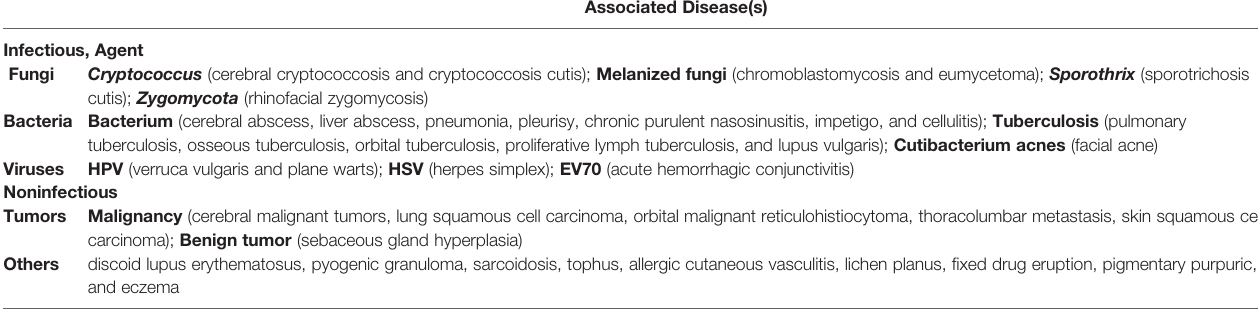
TABLE 7 | Main differential diagnoses of phaeohyphomycosis in China. Associated Disease(s) Infectious, Agent Fungi Cryptococcus (cerebral cryptococcosis and cryptococcosis cutis); Melanized fungi (chromoblastomycosis and eumycetoma); Sporothrix (sporotrichosis cutis); Zygomycota (rhinofacial zygomycosis) Bacteria Bacterium (cerebral abscess, liver abscess, pneumonia, pleurisy, chronic purulent nasosinusitis, impetigo, and cellulitis); Tuberculosis (pulmonary tuberculosis, osseous tuberculosis, orbital tuberculosis, proliferative lymph tuberculosis, and lupus vulgaris); Cutibacterium acnes (facial acne) Viruses HPV (verruca vulgaris and plane warts); HSV (herpes simplex); EV70 (acute hemorrhagic conjunctivitis) Noninfectious Tumors Malignancy (cerebral malignant tumors, lung squamous cell carcinoma, orbital malignant reticulohistiocytoma, thoracolumbar metastasis, skin squamous cell carcinoma); Benign tumor (sebaceous gland hyperplasia)